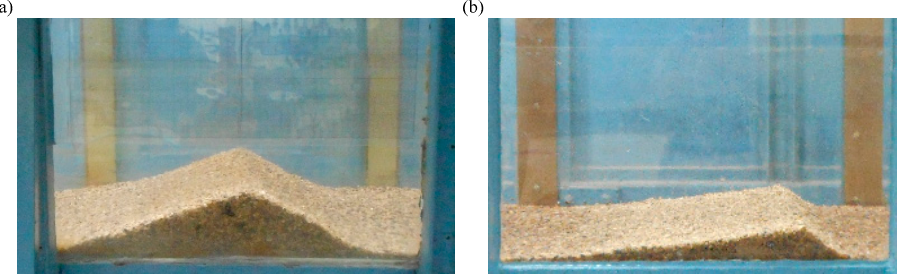
Figure 2. Photographs of isolated dunal bedforms in ( a ) Run 1 and ( b ) Run 2. Flow direction is from left to right.